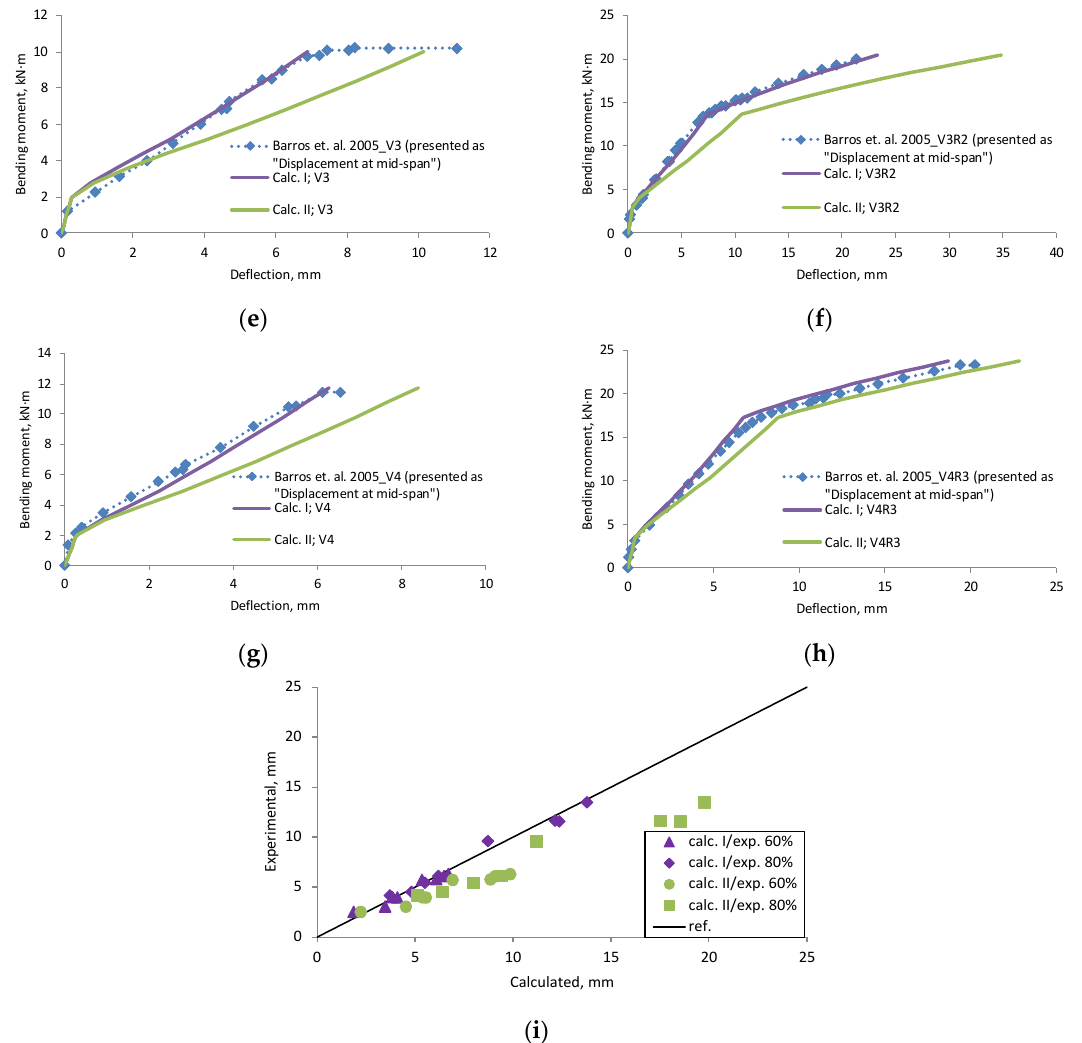
Figure A1. Barros et al., 2005 [24] research beams displacement compared with calculated deflection, ( a ) beam V1; ( b ) beam V1R1; ( c ) beam V2; ( d ) beam V2R2; ( e ) beam V3; ( f ) beam V3R2; ( g ) beam V4; ( h ) beam V4R3; ( i ) scatter of the results at 60% and 80% of the ultimate load.